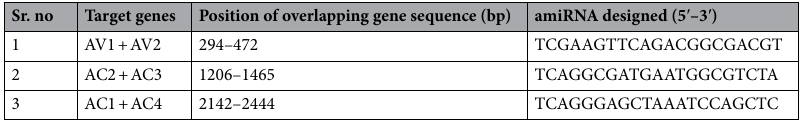
Methylation profiling of transgenics expressing amiRNA. The genomic DNA from T transgenics of C1/C4 (L61, L67), C2/C3 (L42, L43), V1/V2 (L13, L15), VA and WT plants were used for MSAP (methylation-sensitive amplified polymorphism) analysis with 20 primers, which were earlier characterized to be best polymorphic MSAP primers in tobacco (More et al. 25 ). Among 20 primers, 15 primers (Supplementary exhibited very high methylation polymorphism (L67 = 78.73%, L61 = 73.97%), full methylation (L67 = 56.83%, L61 = 40%) and hemi-methylation (L61 = 33.97%, L67 = 21.90%). C2/C3 amiRNA transgenics also showed > 60% methylation polymorphism (L43 = 67.94%, L42 = 61.90%), > 40% full methylation (L42 = 40.63%, L43 = 40.63%) and > 20% hemi-methylation (L43 = 27.30%, L42 = 21.27%). The V1/V2 amiRNA transgenics showed lower val-